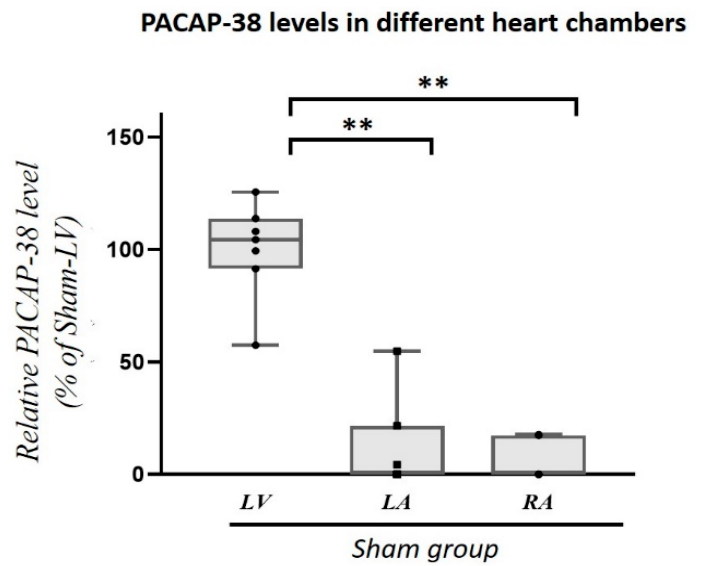
Figure 1. PACAP-38 levels of the different heart chambers (LV: left ventricle, LA: left atrium, RA: right atrium). In healthy, Sham-operated animals PACAP-38 level of the left ventricle (LV) was significantly higher than in left (LA) or in right atrium (RA). Data are expressed in ratio of Sham-LV PACAP-38 levels. The boxes show the interquartile ranges, and the whiskers indicate the most extreme observations. The middle line within the boxes represents the median value. Individual values are presented as black dots and squares. One-way ANOVA with Tukey post-hoc, ** p < 0.001 vs. Sham-LV group. n = 7–8.